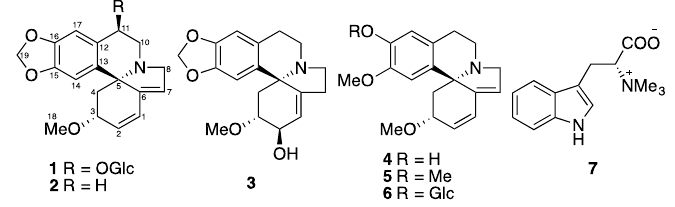
Figure 1. Structure of Compounds 1 – 7 .